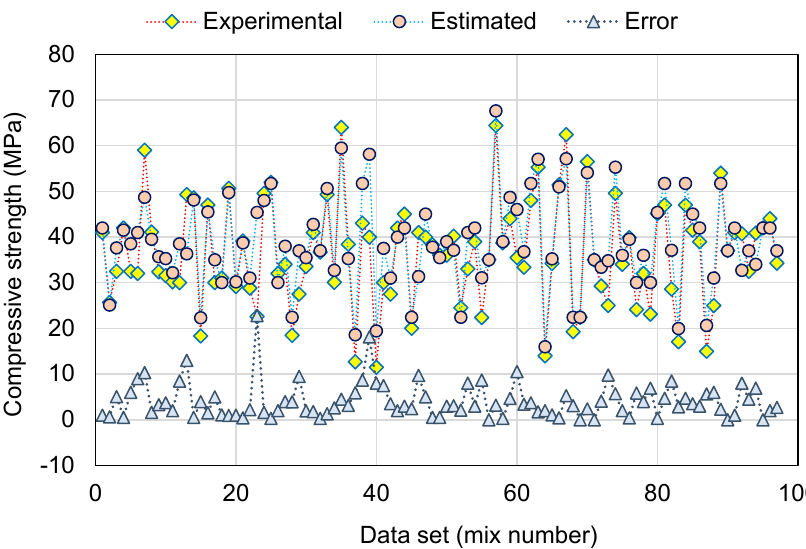
Figure 13. Distribution of experimental, estimated, and error values for the AdaBoost regressor model.